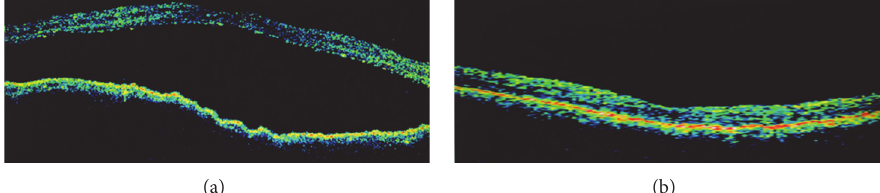
Figure 3: (a) OCT raster line scan of the right eye showing the presence of large SMD with underlying choroidal folds. (b) OCT raster line scan of the same eye showing resolution of SMD and choroidal